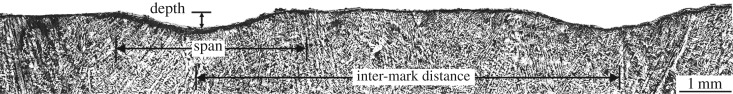
Two adjacent oscillation marks and typically observed microstructure underneath them.